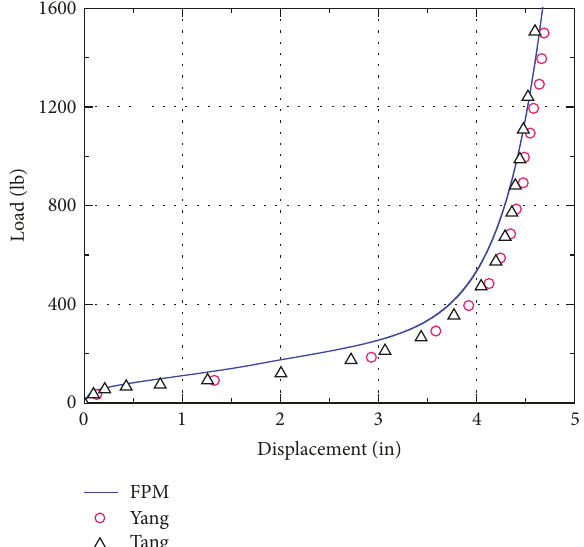
Figure 16: Load-displacement of beam free end (elastic).